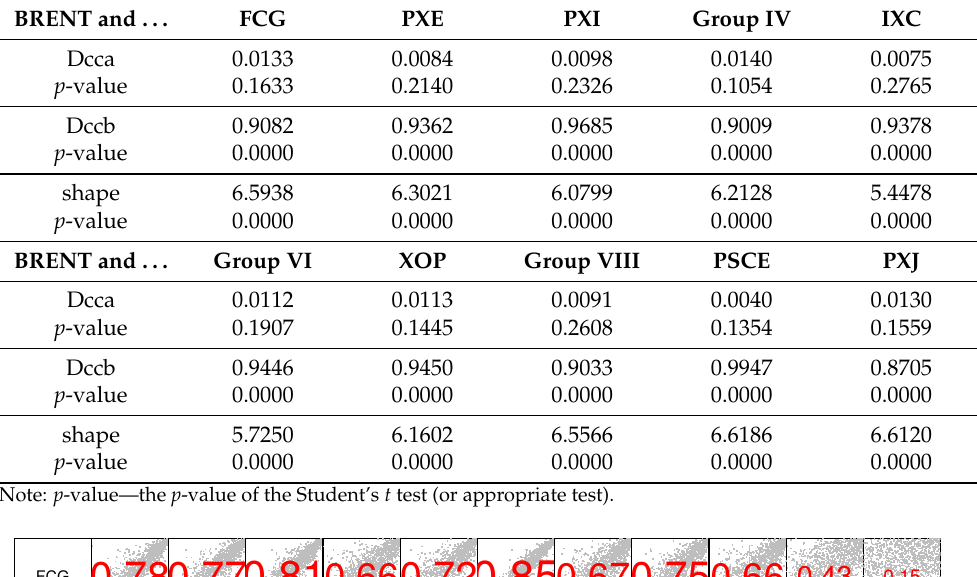
Table A6. DCC estimation results.